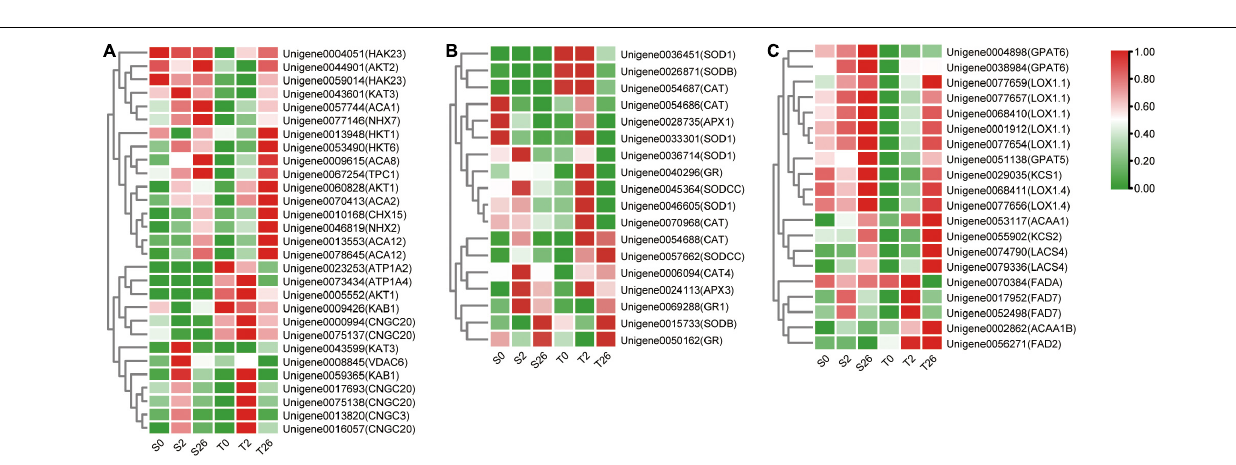
FIGURE 8 | Heatmap of the relative expression of the DEGs involved in Na + , K + and Ca 2 + transport (A) , ROS-scavenging (B) and fatty acid metabolization (C) in Magnum Salt and Adrenalin under salt stress. FPKM was used for representing the expression abundance of genes. The clustered heatmap was portrayed after normalized with zero-to-one scale method using the TBtools